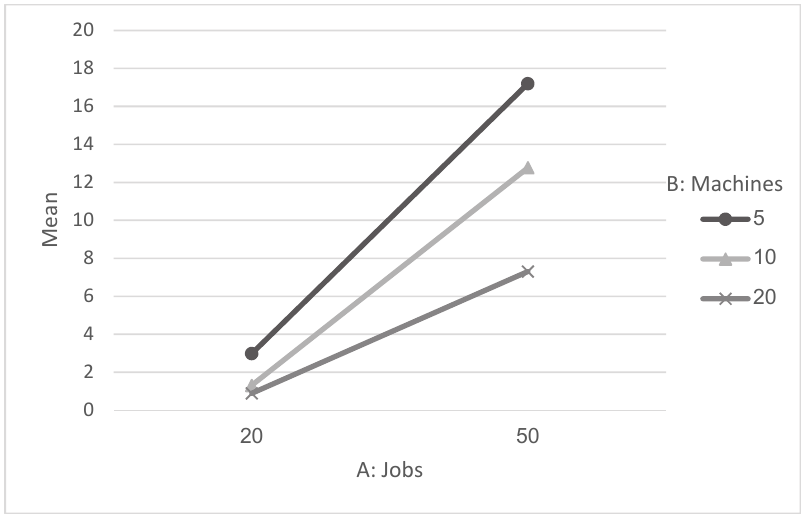
Fig. 11. Jobs-Machines Interaction plot for ratio